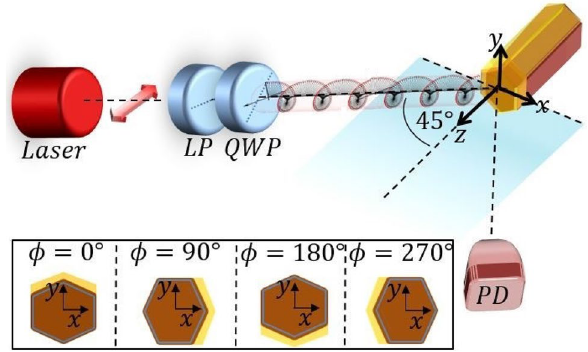
Figure 2. Schematic of the experimental set-up for extrinsic chirality in reflection. Inset: orientations of the NW ensemble, given as a clockwise rotation around the z-axis. The incidence angle is fixed at 45°.